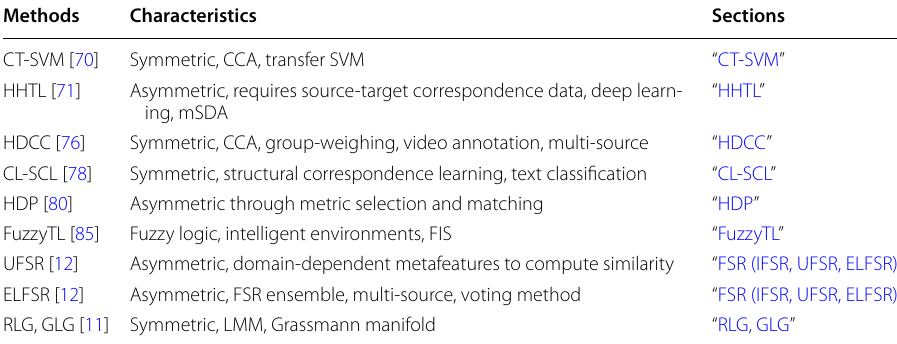
Table 3 Surveyed HTL methods which require no target labels